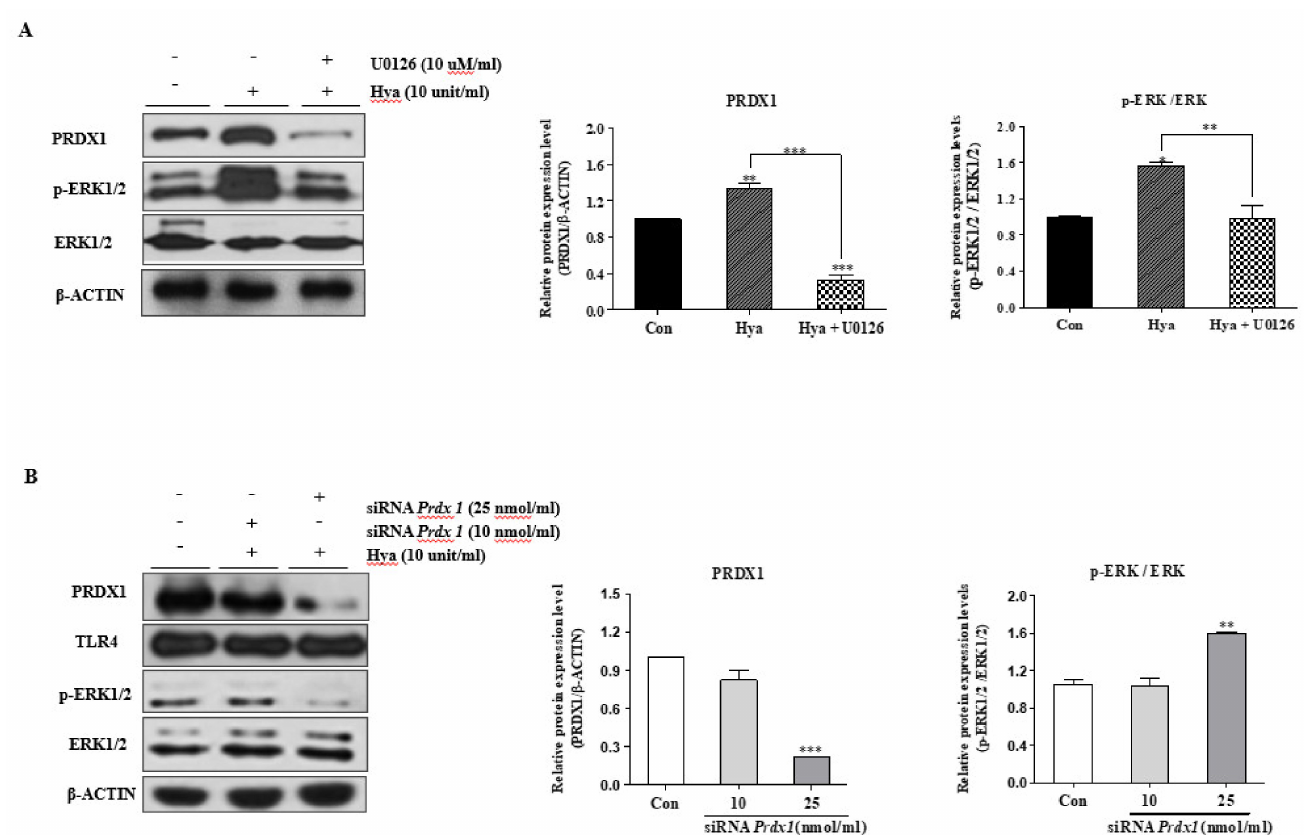
Figure 4. The mutual relationship of PRDX1 and ERK1/2 MAP kinase signaling in ovulated COCs using an ERK inhibitor or siRNA Prdx1 . ( A ) Protein levels of PRDX1, ERK1/2, and p-ERK1/2 were identified by Western blot analysis in ovulated COCs after treatment with Hya or the ERK-specific inhibitor U0126. ERK1/2 inhibitor (U0126)-dependent changes in the expression of PRDX1 in COCs were cultured with Hya (10 units/mL) treatment. ( B ) siRNA Prdx1 -dependent changes in the activation of TLR4-mediated ERK1/2 pathways in ovulated COCs were cultured with Hya (10 units/mL) treatment. Ovulated COCs were cultured with Hya for 15 min for ERK1/2 activation; after 2 h, they were treated with siRNA Prdx1 (10 and 25 nmol/mL). We performed a Western blot analysis to confirm the protein levels of MAPK signaling genes (p-ERK1/2 and ERK1/2), PRDX1, and TLR4 in ovulated COCs after with Prdx1 siRNA treatment. These gene protein levels were normalized to β -ACTIN expression as a control. The p-ERK1/2 was normalized to total ERK1/2. Histogram values of the densitometry analysis were obtained using Image J software. Bar graph data represent the least-squares means ± SEM (30 COCs per group) of three independent experiments. *, p < 0.05; **, p < 0.01; ***, p < 0.001 for analysis of these data via Dunnett’s multiple comparison test compared with the control